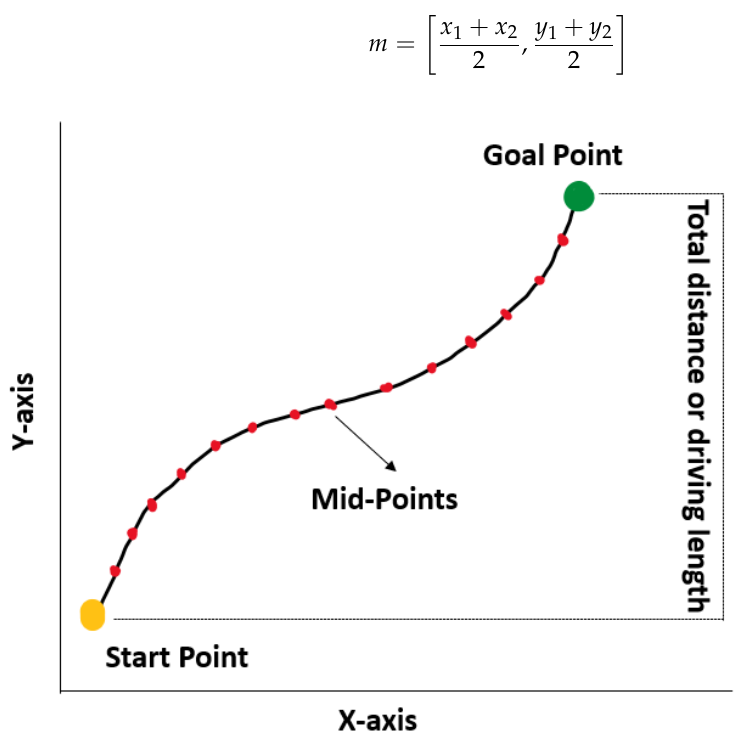
Figure 6. Travel length estimation. Midpoints are used as the checkpoints for the navigation of AVs.